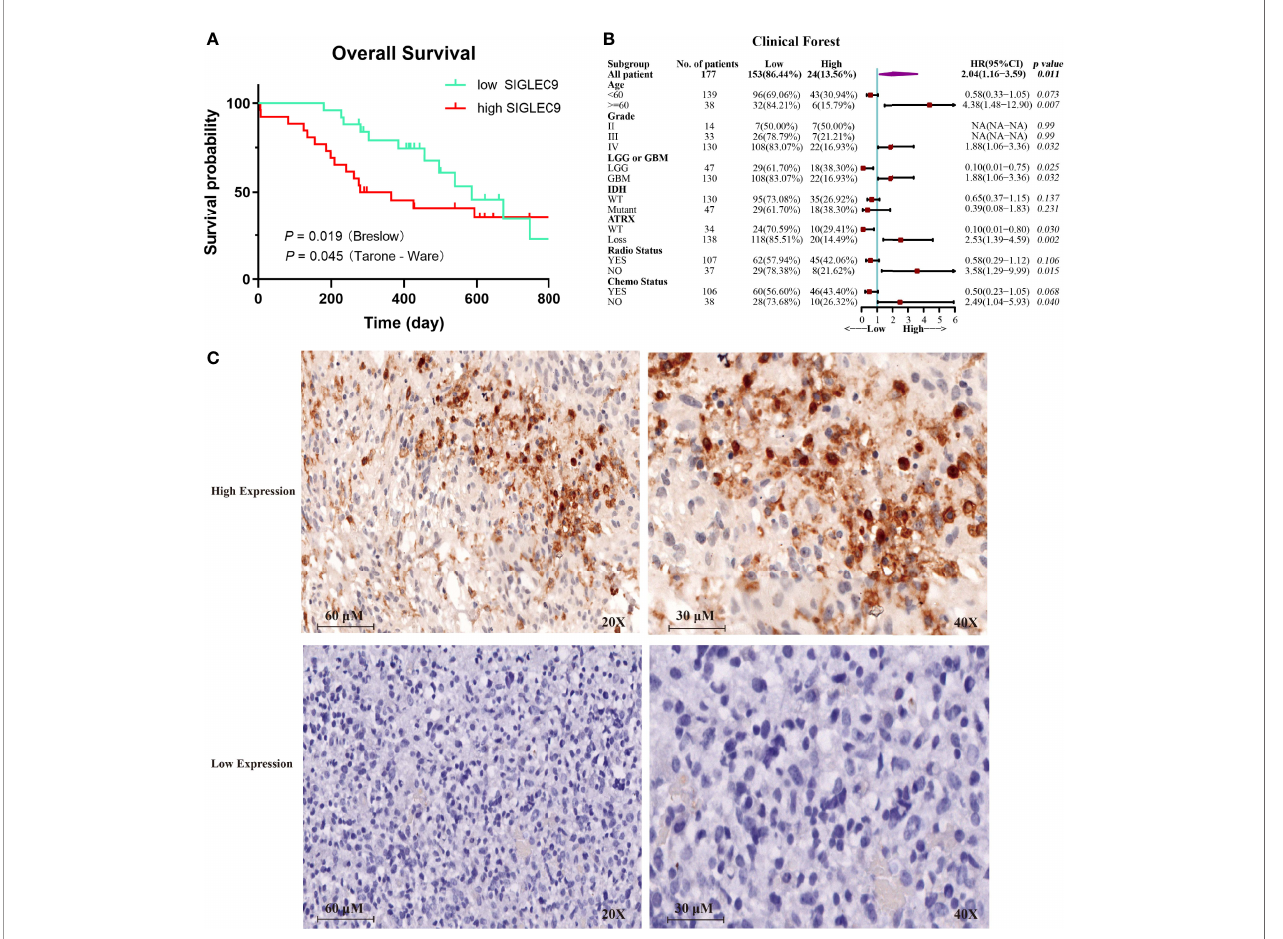
FIGURE 3 | The expression of SIGLEC9 in 177 glioma patients. (A) The glioma patients with a high SIGLEC9 expression ( n = 26) had a shorter survival probability than those patients with a low SIGLEC9 expression ( n = 25) ( P = 0.019). (B) Clinical characteristics of SIGLEC9 expression in glioma patients. In glioma patients with the following characteristics — age ≧ 60 years ( P = 0.007), grade IV ( P = 0.032), glioblastoma ( P = 0.032), alpha thalassemia/intellectual disability syndrome X-linked loss ( P = 0.002), without radiotherapy ( P = 0.015), or without chemotherapy ( P = 0.040), respectively — those with a high SIGLEC9 expression had a shorter survival probability than those with a low SIGLEC9 expression. (C) Immunohistochemical staining of SIGLEC9 from glioma patients of Sanbo Brain Hospital Capital Medical